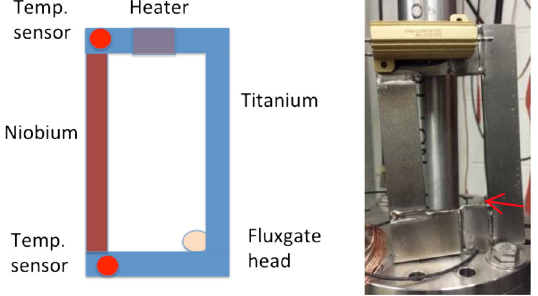
FIG. 3. Setup to measure the thermocurrents. On the left is a sketch of the arrangement with the principle components, on the right is a photograph of the setup with the arrow pointing to the location of the flux gate probe. The size of the frame was 12.5 cm by 7.75 cm on the outside and 7.5 cm by 3.75 cm inside, the thickness was 0.25 cm.